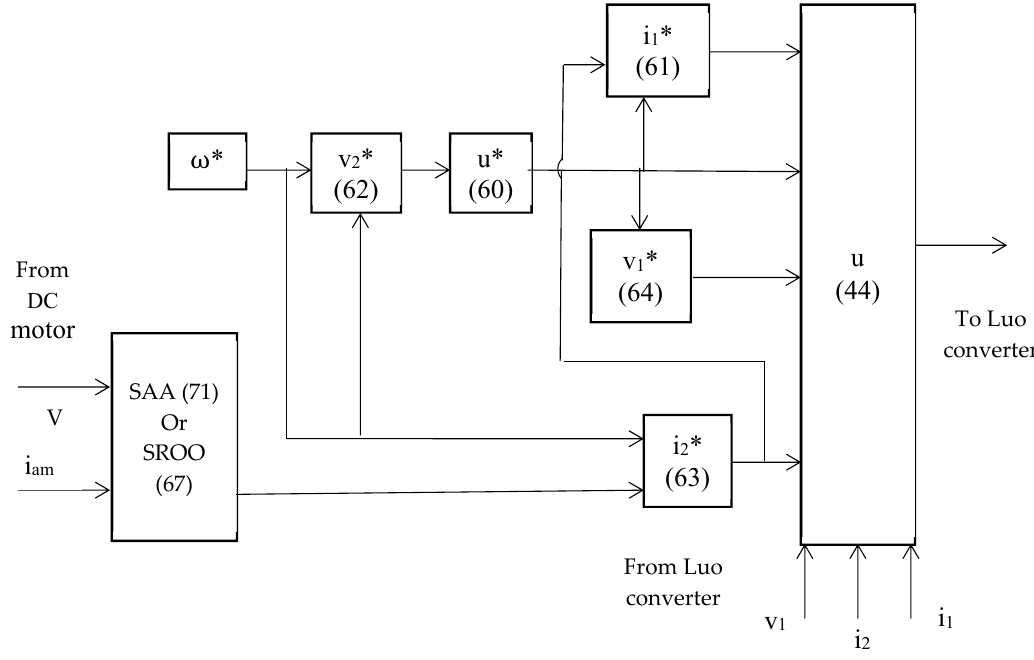
Figure 4. Flow diagram for the ETEDPOF implementation.